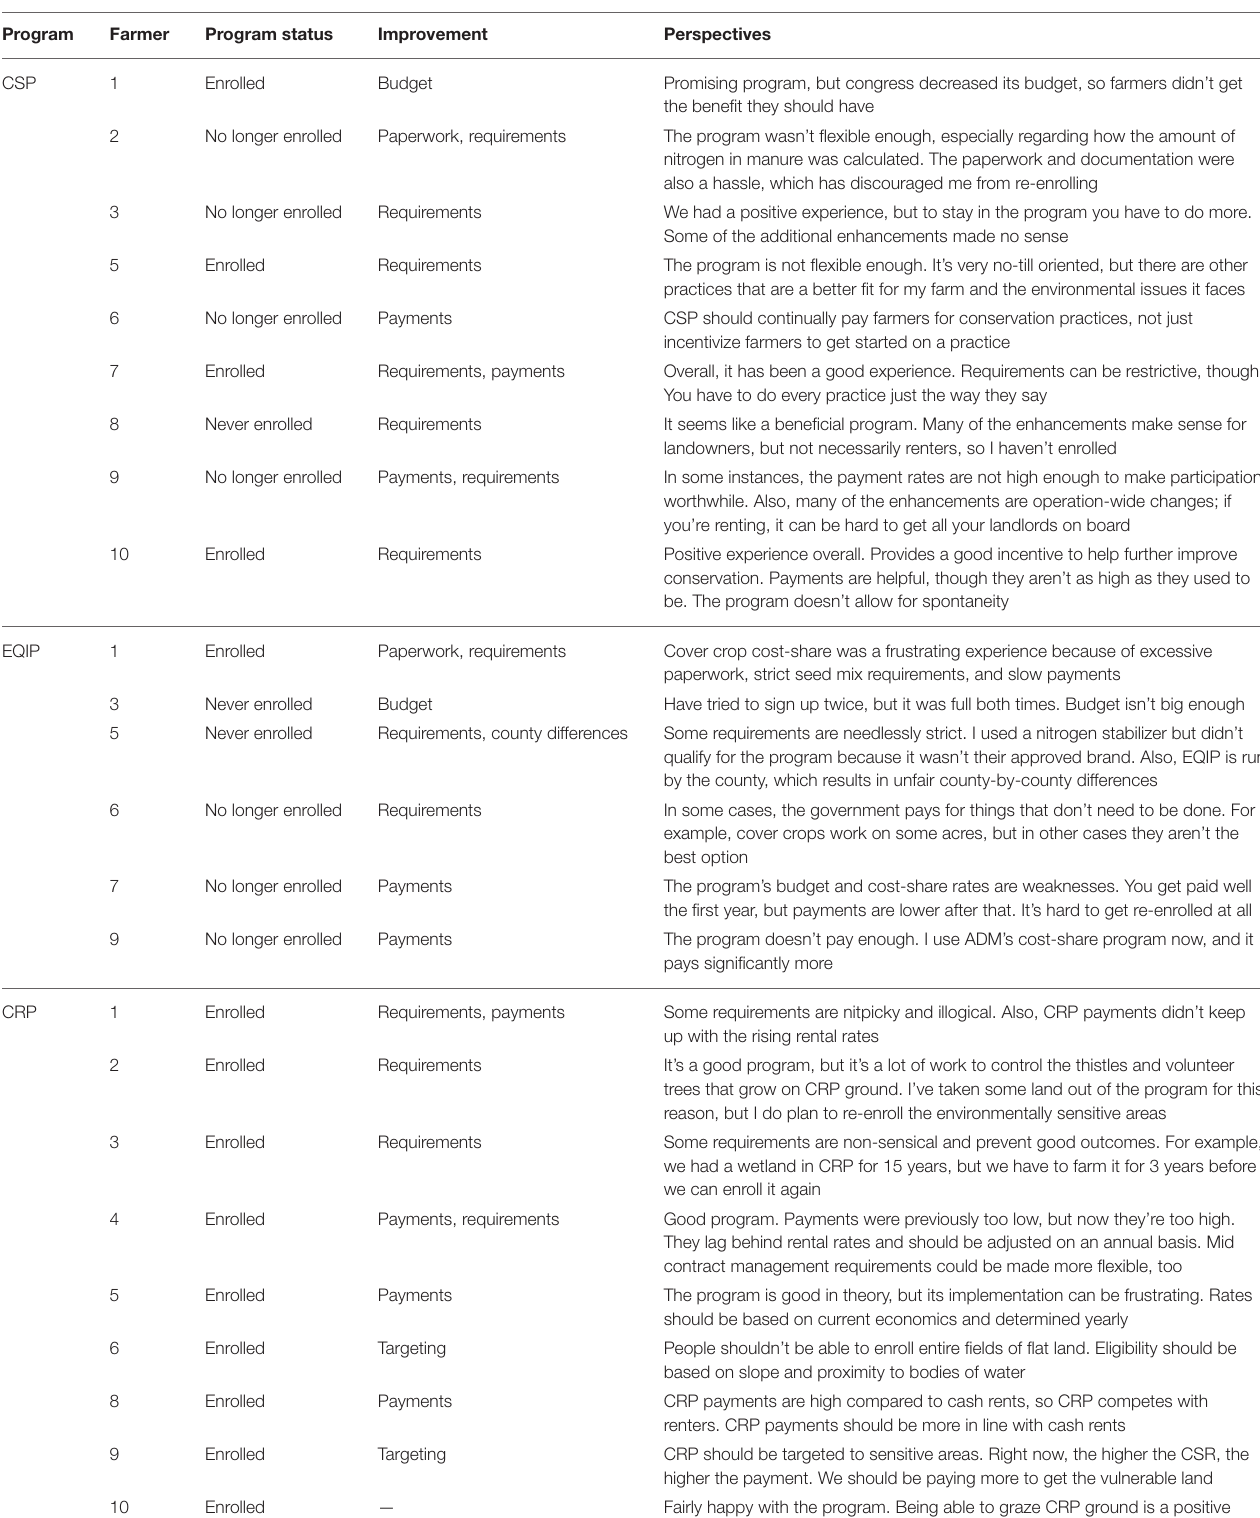
TABLE 2 | Farm environmental leaders’ perspectives on conservation programs. Program